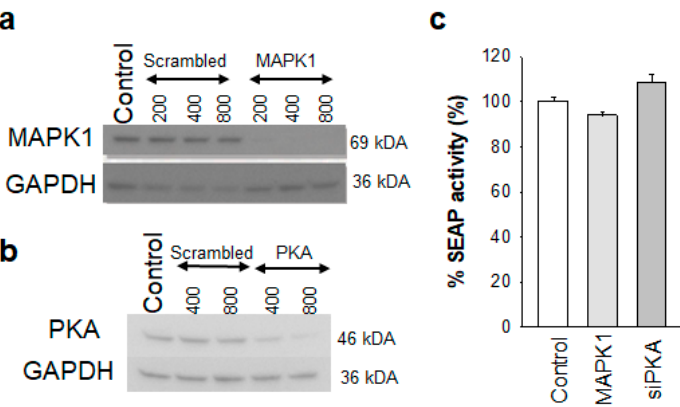
Figure 7. Effect of MAPK1 and PKA knockdown of HIV-1 latency reversal in 24ST1NLESG cells. ( a ) Western blot analysis of MAPK1 knockdown using different siRNA concentrations; ( b ) Western blot analysis of PKA knockdown using different siRNA concentrations; ( c ) effect of MAPK1 and PKA knockdown on HIV-1 latency reversal mediated by TNF- α in 24ST1NLESG cells. Data are shown as the mean ± standard deviation from at least three independent biological replicates. Statistical sig- nificance evaluated using Mann–Whitney U test.